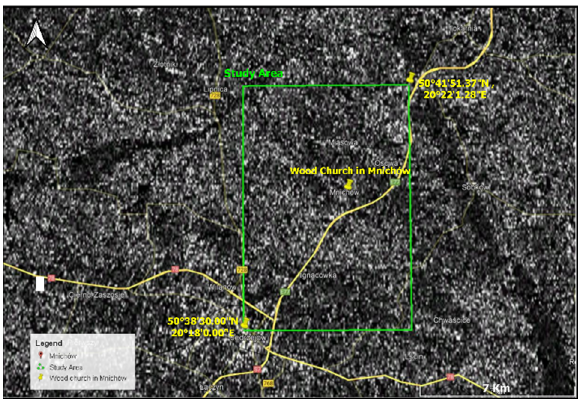
Figure 15. The raw interferogram picture of coherence (value of coherence from 0 to 1). From 0.4 to 1 is good coherence (white colour) and near to 0 is bad (no satellite signal or bad value of signal) and has black colour. The standard filtered coherence value > 0.4 was used in the calculations.